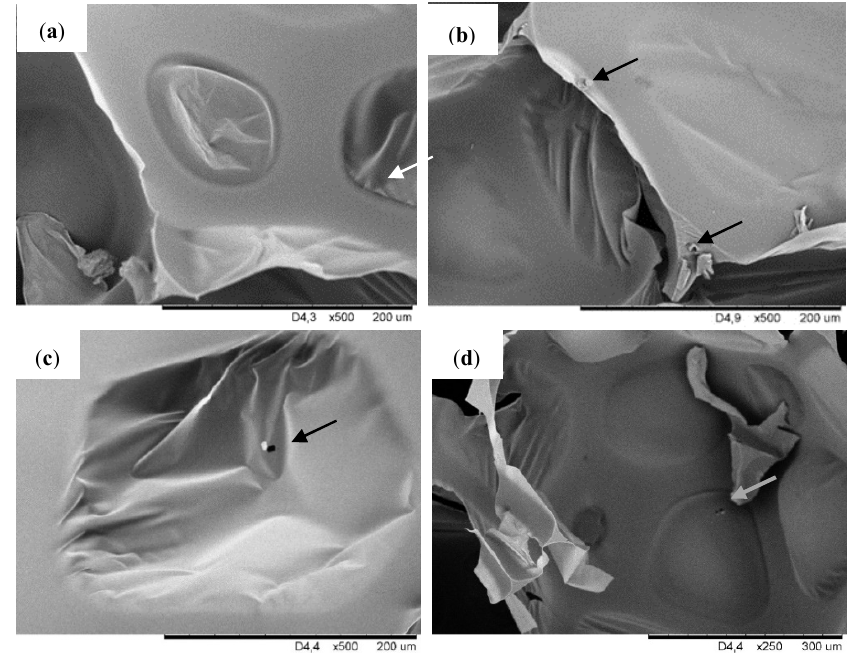
Figure 2. SEM images of ( a ) PUR-0, ( b ) PUR-POSS-Ar-Cl, ( c ) PUR-POSS-Pr-Cl and ( d ) PUR-POSS- Ar-Et-Cl.